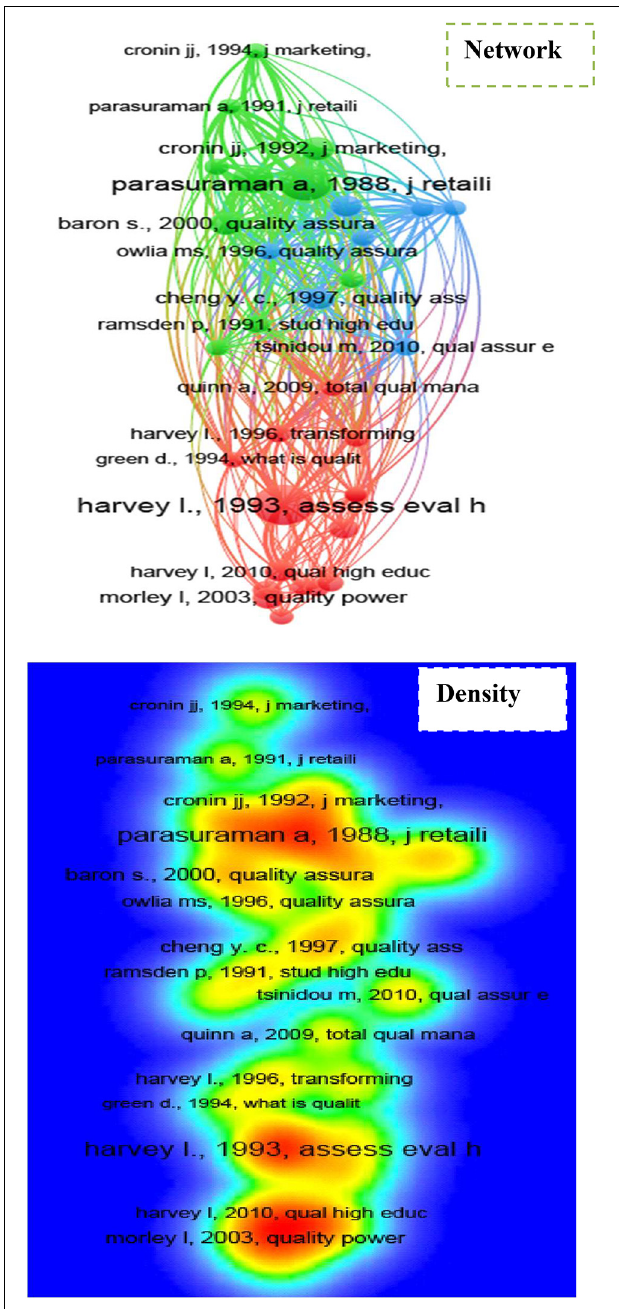
FIGURE 3 | Network and density of the most referenced research papers in the field of quality of higher